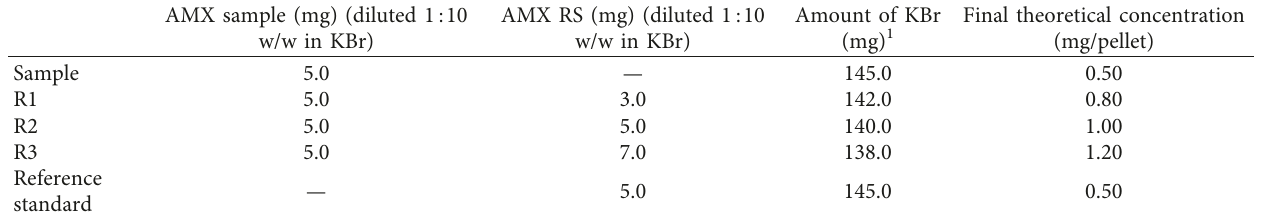
Table 1: Preparation of pellets for the recovery assay of the method of FT-IR spectrophotometry for amoxicillin. AMX sample (mg) (diluted 1:10